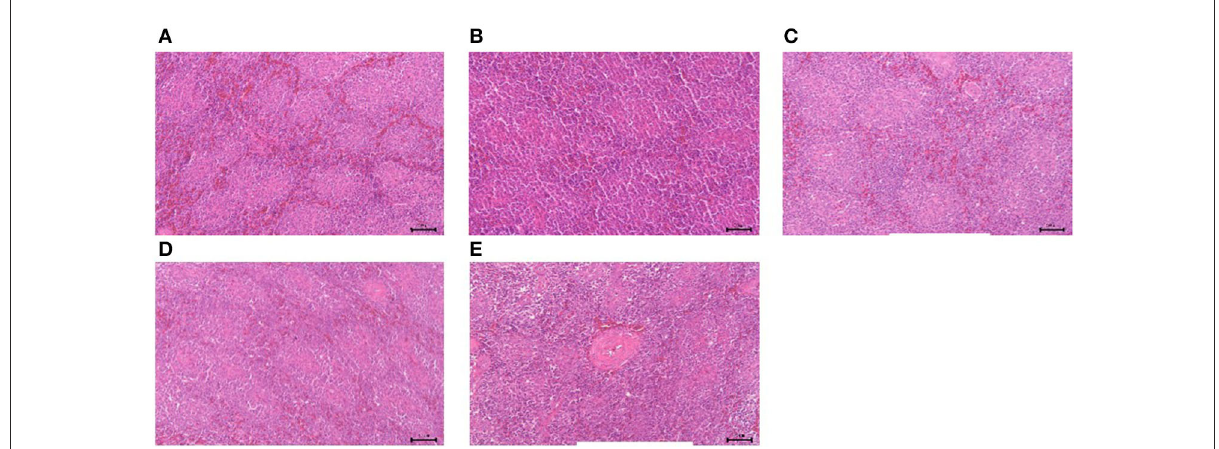
FIGURE9 Histological changes of the spleen in each group. (A) GPS-1L group; (B) GPS-1M group; (C) GPS-1H group; (D) VC group; (E) BC group. H&E staining; 200 × magnification.